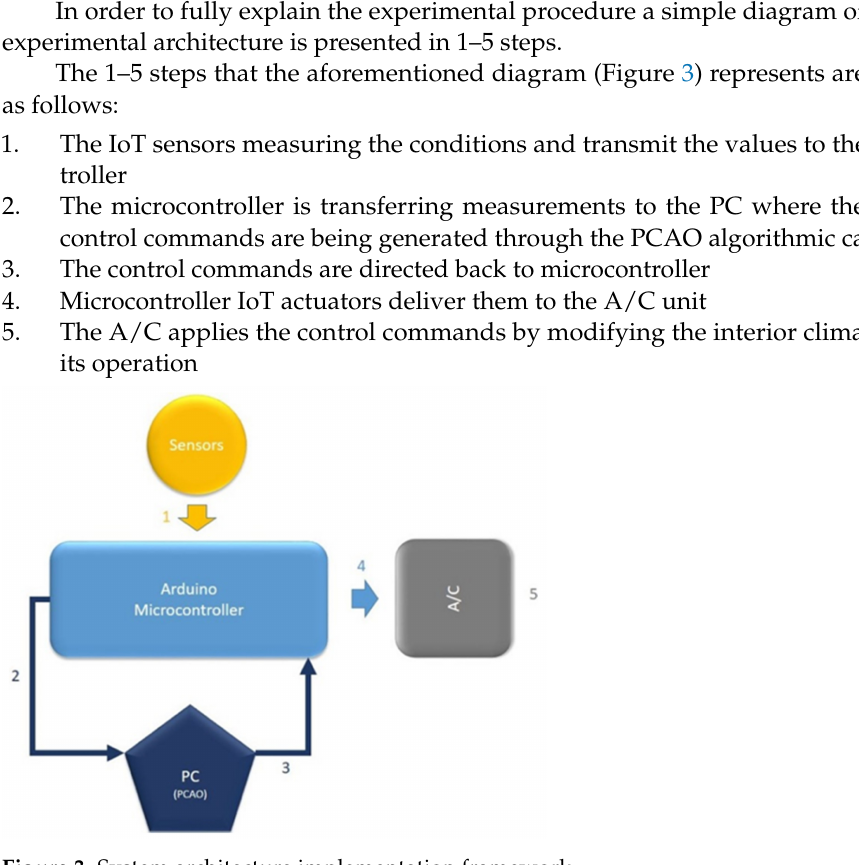
Figure 3. System architecture implementation